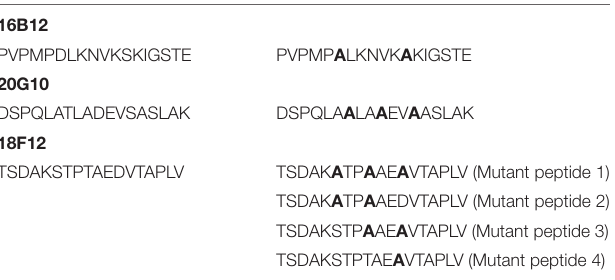
TABLE 2 | Wild-type and mutated set of peptides used for competition ELISA design. 16B12